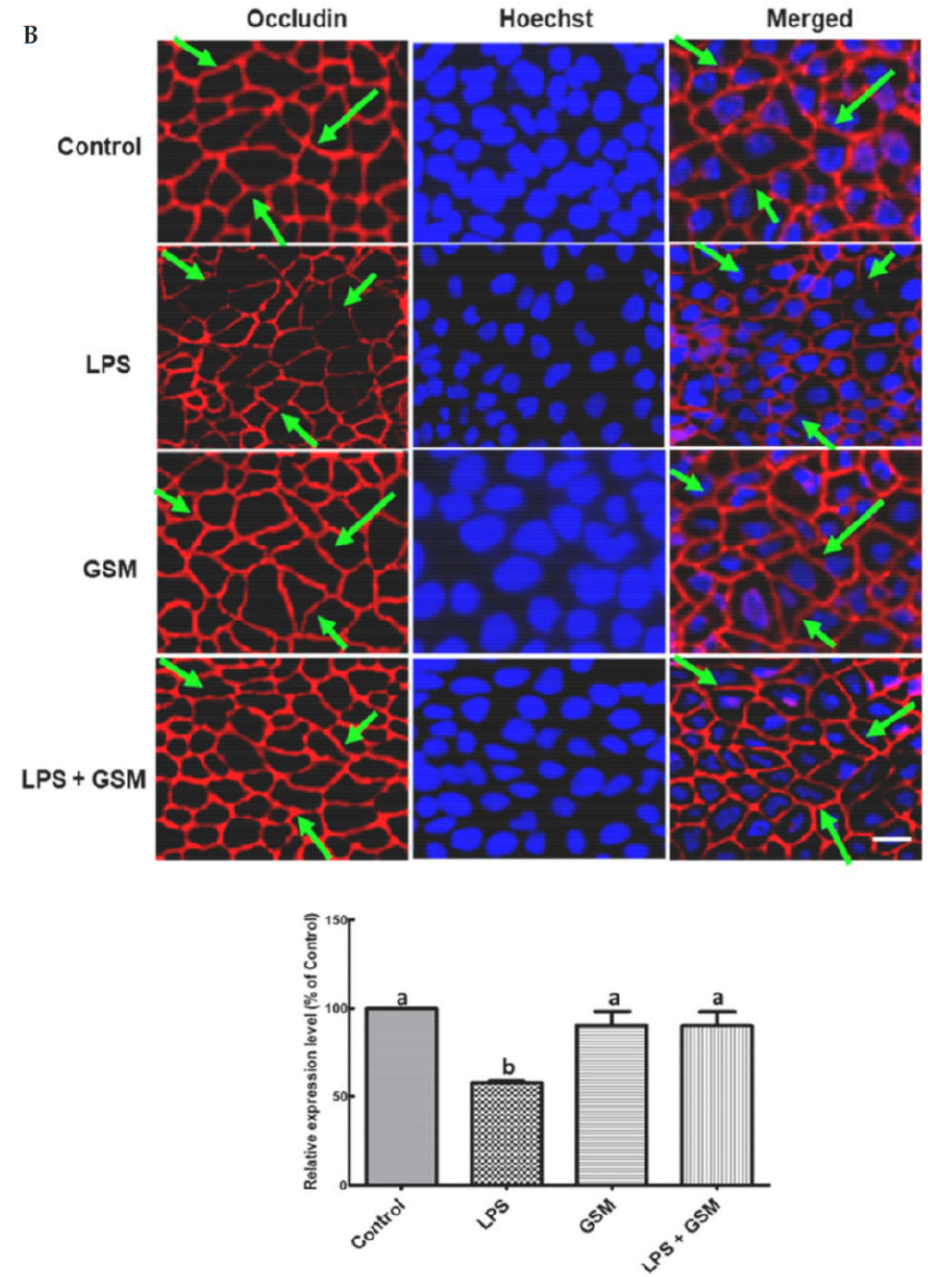
Figure 3. Identification of tight junction proteins in LPS-treated Caco-2 by immunofluorescence staining of CLDN4 ( A ) and OCCL ( B ). Confluent Caco-2 monolayers were treated for four hours with LPS or media (control), followed by 24-h incubation with GSM extract, as described in the Materials and Methods section. At the end of experiment, cells were stained with CLDN4 (green), OCCL (red) for junction proteins visualization, and with Hoechst (blue) for nuclei detection. Merged images show both tight junction proteins and nuclei staining. The arrows showed the intact junction protein expression (in Control, GSM and LPS + GSM samples) and deregulated expression of junction proteins (in LPS-treated cells), respectively. Scale bar = 20 µ m. The charts from the right indicate the analysis of CLDN4 and OCCL relative fluorescence intensity using Image J (Fiji), expressed as percentages of Control samples. Anova-one way followed by Fisher tests were used to analyze the effect of experimental treatments on protein expression. a,b,c Groups with unlike superscript letters were significantly different ( p <